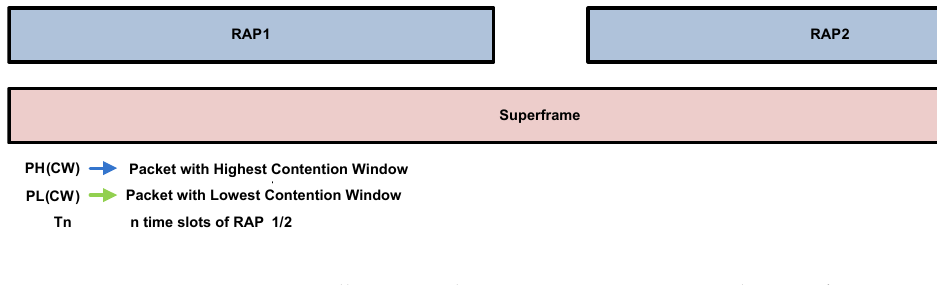
Figure 7. Collision avoidance scenario in CW assisted CSMA/CA.